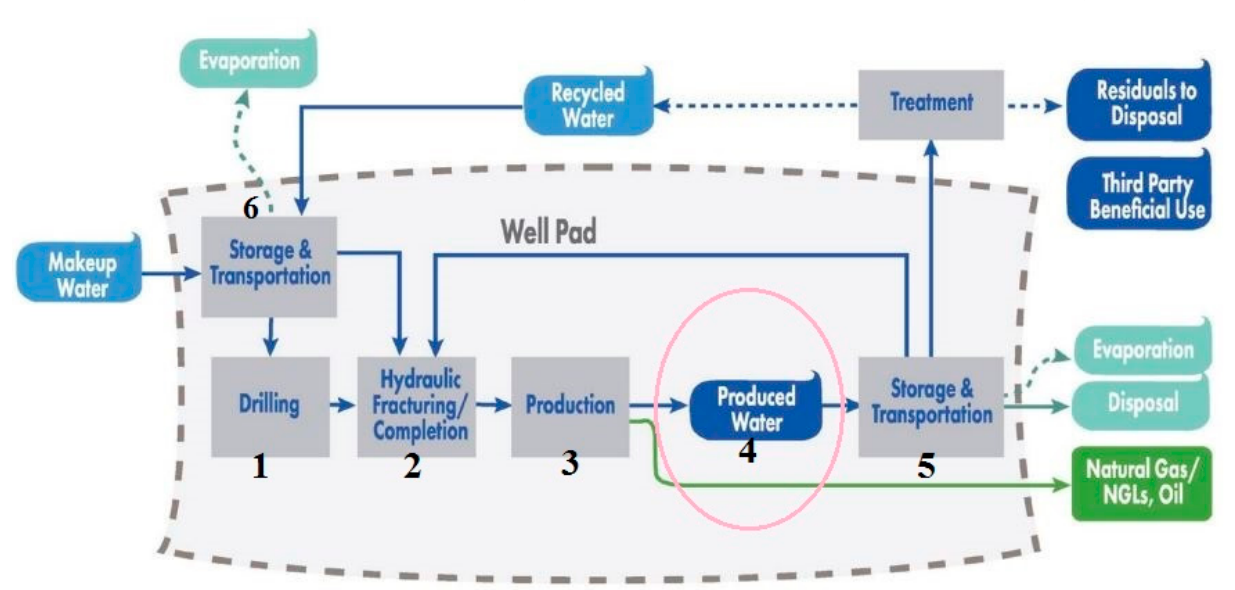
Figure 1. Water life cycle of PW in an unconventional oil and gas production [28].